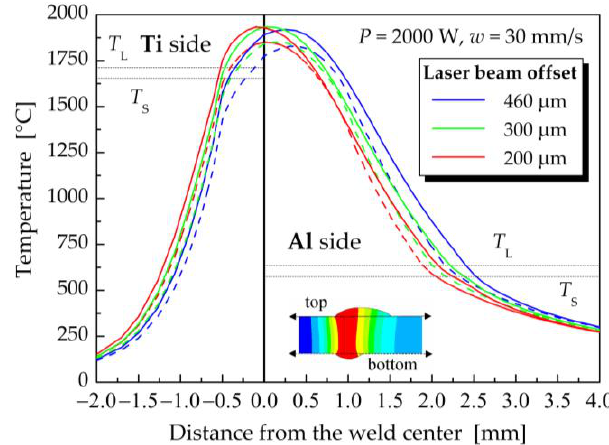
Figure 11. Dependence of the temperature on the distance from the weld centerline for the considered offsets of the laser beam on the top surface (solid lines) and bottom surface (dashed lines) of welded – brazed plates (the laser power of 2000 W and the welding speed of 30 mm·s −1 ).